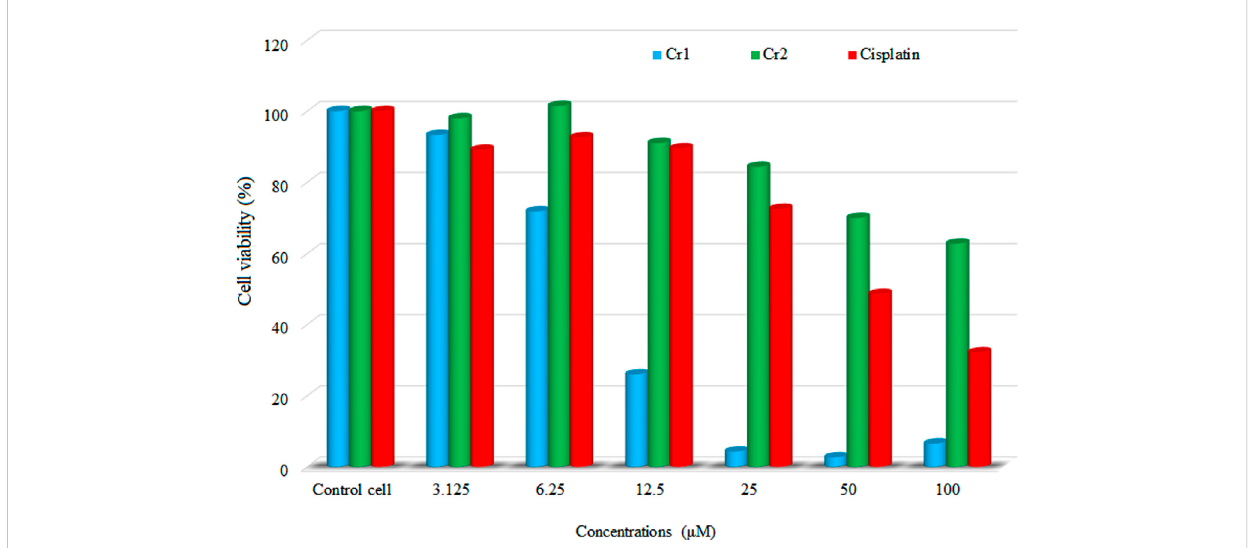
FIGURE 6 Cell viability pro fi le of the synthesized complexes against MCF-7 cells.